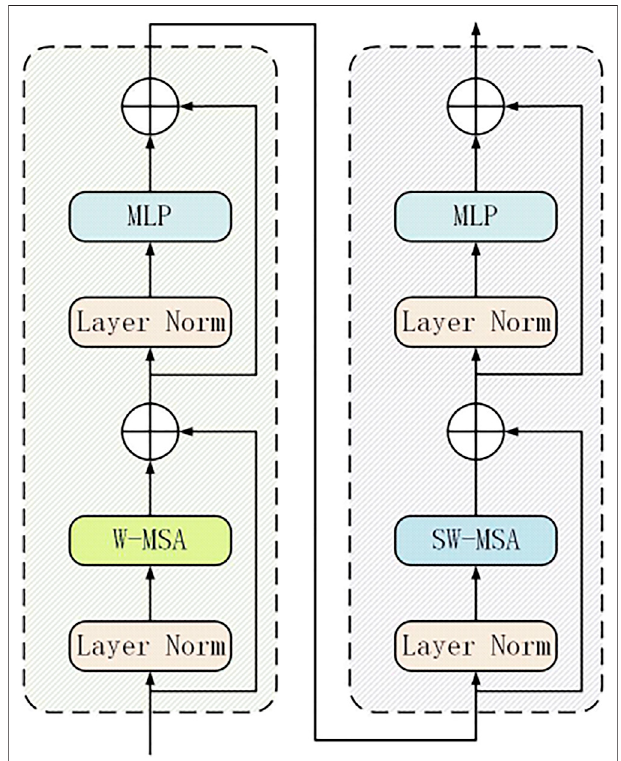
FIGURE 3 | Two successive Swin transformer